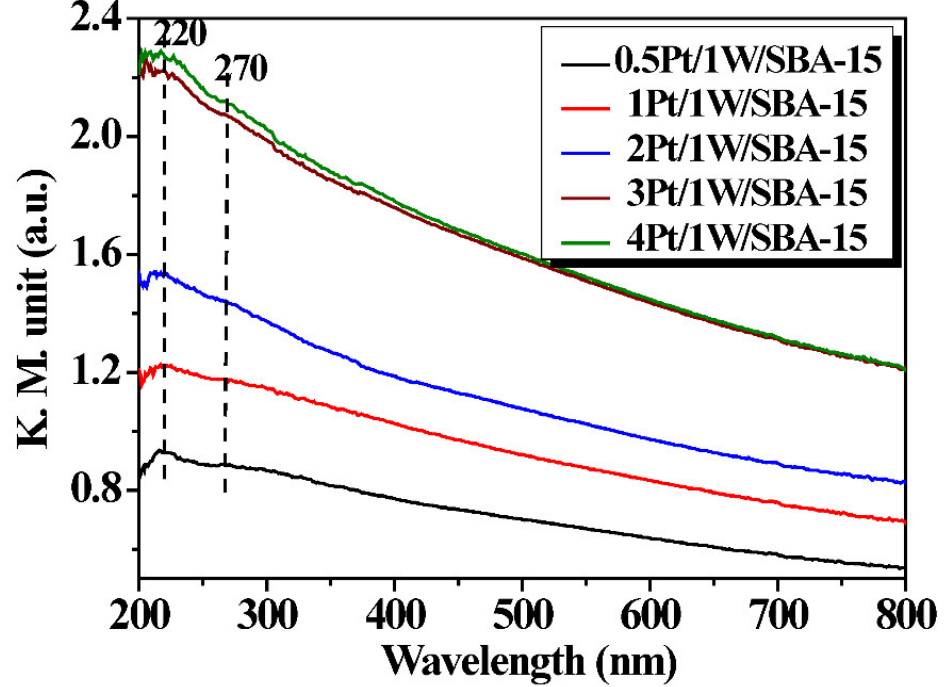
Figure 3. Diffuse reflectance UV-visible spectra of Pt/W/SBA-15 catalysts. X-ray photoelectron (XP) spectroscopy provided information on the electronic struc- ture and oxidation state of Pt and W species. Representative XP spectra of 4Pt/1W/SBA-15 from Pt 4f and W 4f core levels are presented in Figure 4. The Pt 4f lines appeared in the binding energy (B.E.) range of 68–78 eV and those of W 4f appeared at 34–40 eV. The spectral lines were deconvoluted and assigned as 4f 7/2 and 4f 5/2 spin-orbit doublet (Table 1). Based on the position of spectral lines it was concluded that Pt in these catalysts was present in the zero oxidation state and W was present in the +6 oxidation state. Any marginal changes in Pt and W XP line positions with increasing Pt content were due to changes in their close contact and changes in the particle size of Pt as noted from TEM studies. The increase in the B.E. value of Pt 4f 7/2 line (from 71.2 to 71.6 eV) and decrease in the B.E. value of W 4f 7/2 line (from 36.5 to 35.7 eV) was due to electron transfer from the Pt to the W species at higher Pt loadings that facilitated the synergistic catalytic hydrogenolysis activity. The structural and spectroscopic characterizations revealed that Pt and W species in these catalysts were dispersed and in improved contact at higher Pt loadings (3–4 wt%). Tungsten at 1 wt% loading was in an isolated WO x species. Pt was in zero and W was in the +6 oxidation